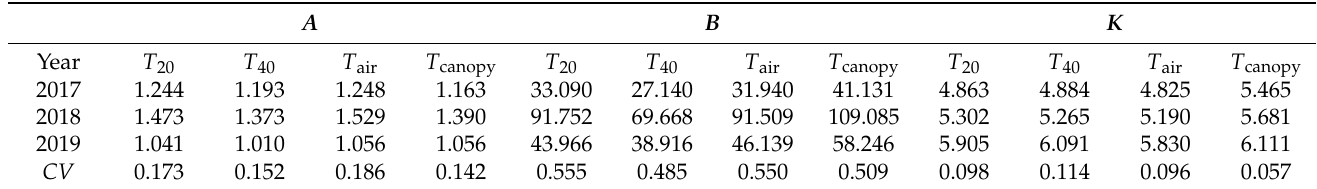
Table 1. Calibration results and inter-annual differences of the N-logistic model parameters with T 20 , T 40 , T air , and T canopy in